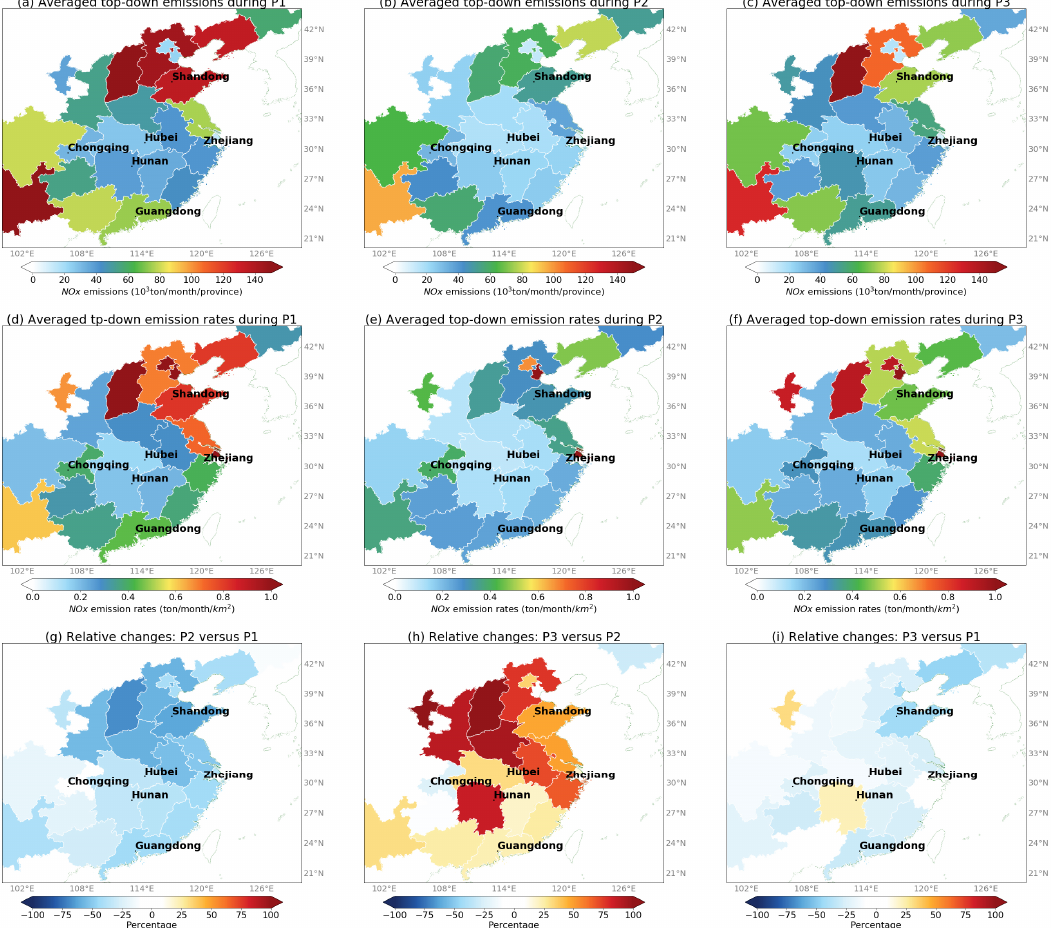
Figure 2. (a–c) Top-down NOx emissions summed up in each province during the three periods. (d–f) Top-down NOx emission rates (emission per area) of each province during the three periods. (g–i) Relative changes of top-down emissions between the periods.